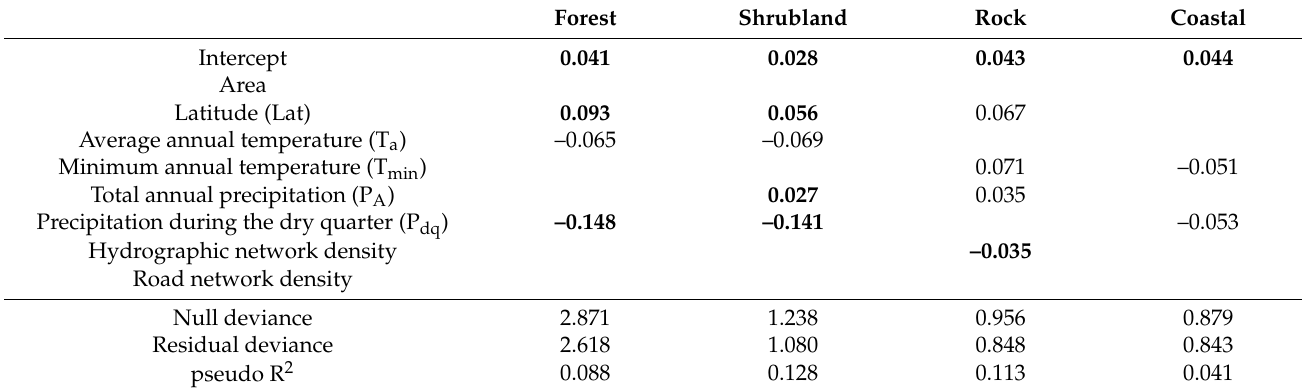
Table 4. Summary of the GLM analysis across each habitat group. Grassland and riparian—wetland habitat groups are not presented separately, since we did not detect significant differences between the two reference periods (see Table 2). Boldface indicates statistically significant values at a =